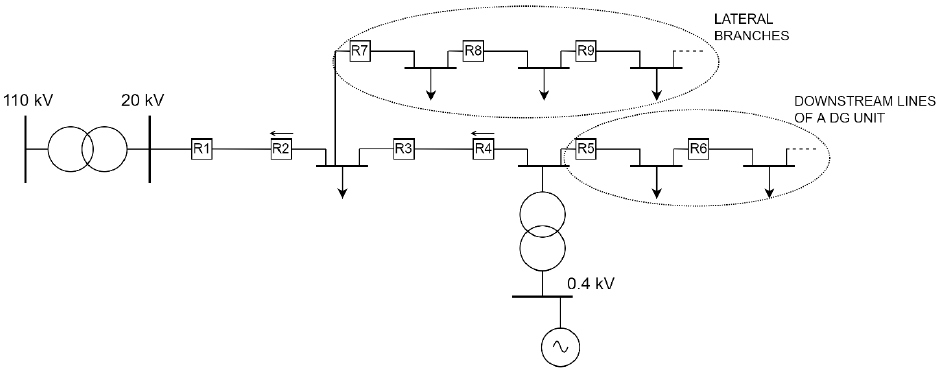
Figure 10. An example of a partially meshed distribution network with an updated protection phi- losophy.